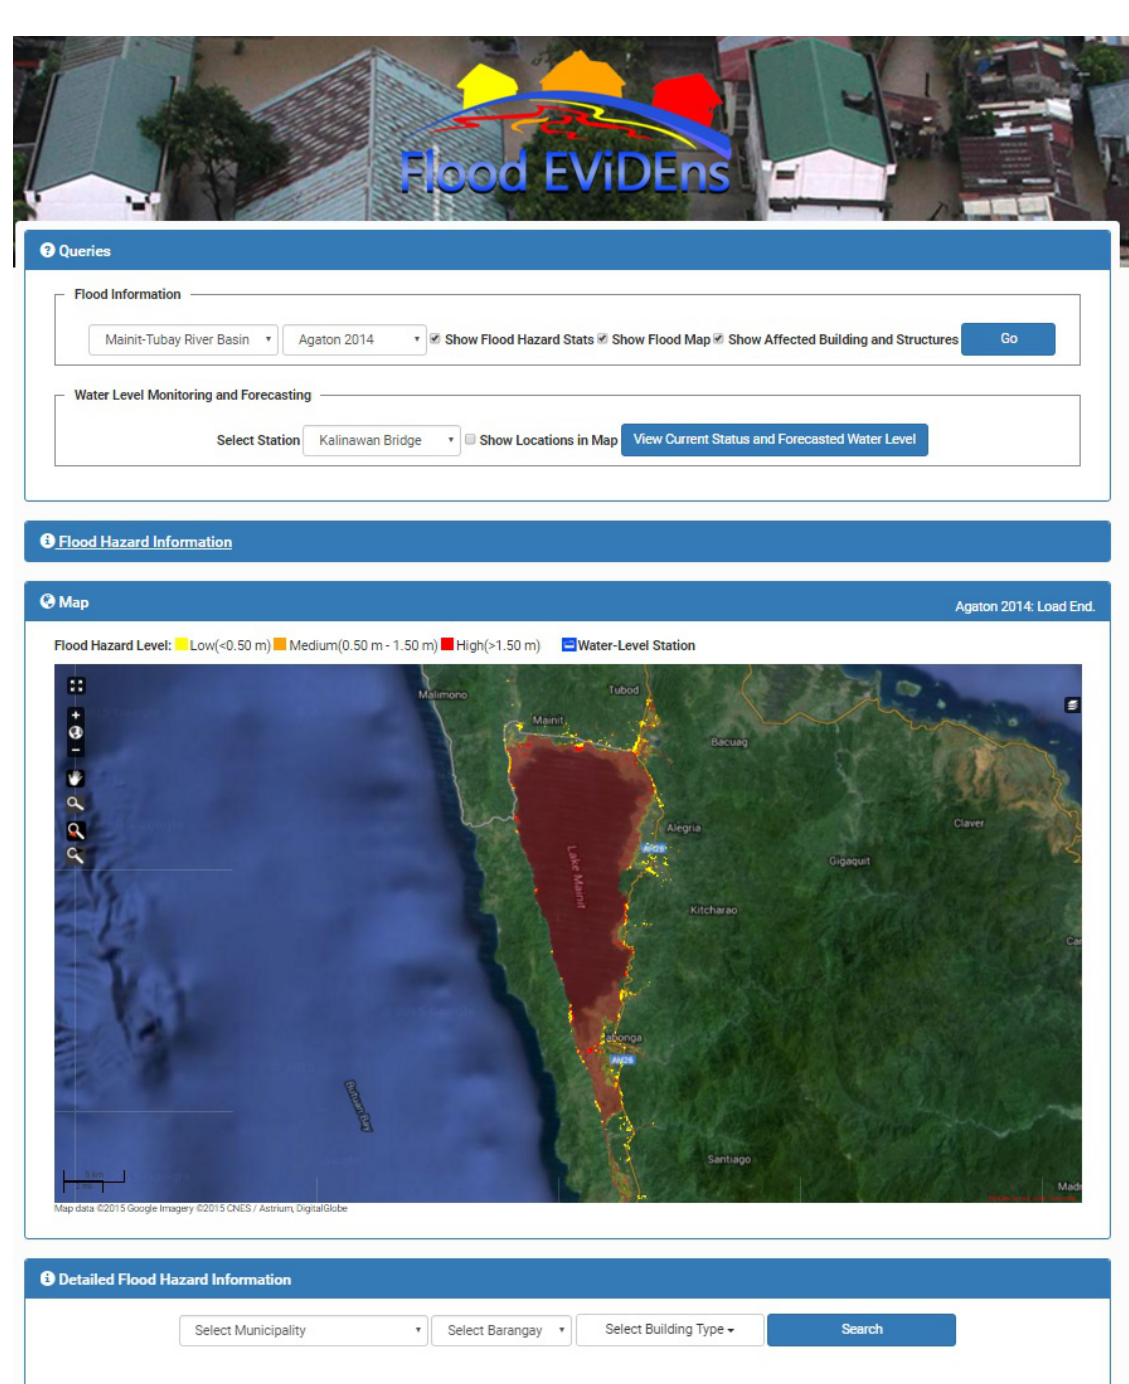
Figure 5: Graphical user interface of Flood